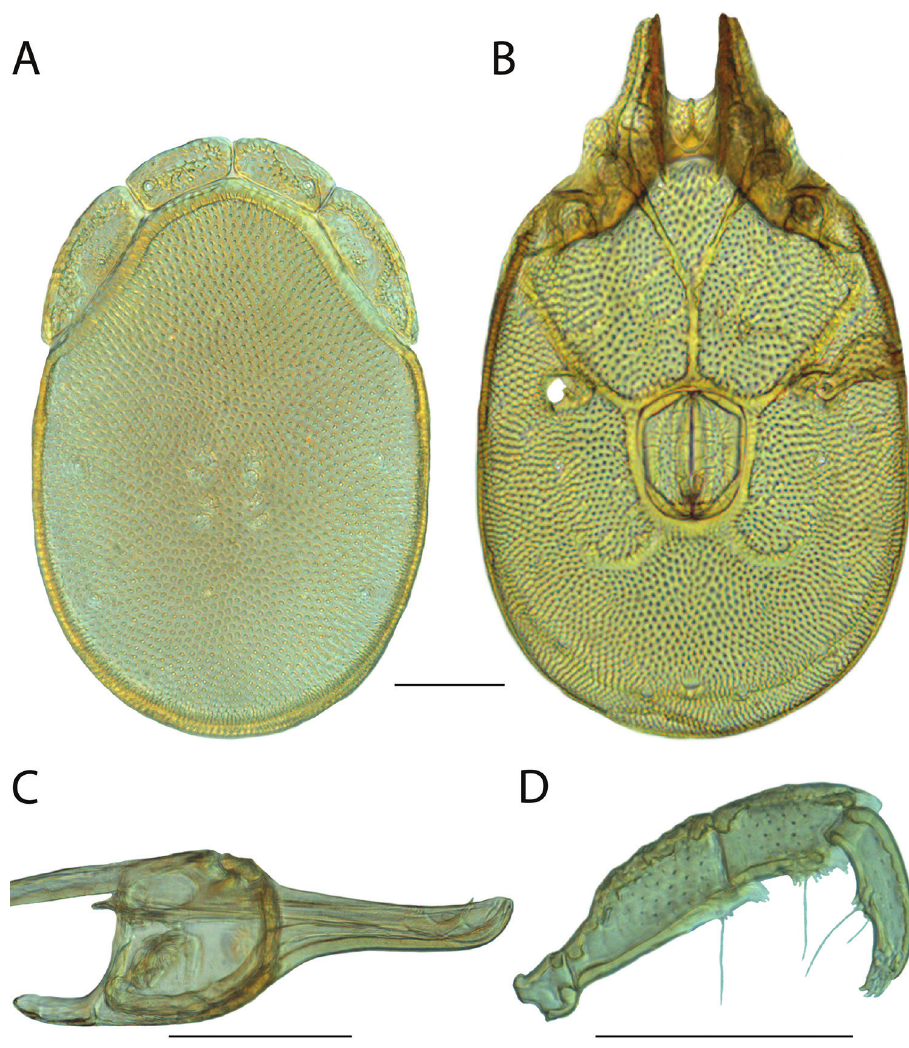
Figure 192. Torrenticola pinocchio sp. n. male: A dorsal plates B venter (legs removed) C subcapitulum D pedipalp (setae not accurately depicted). Scale = 100